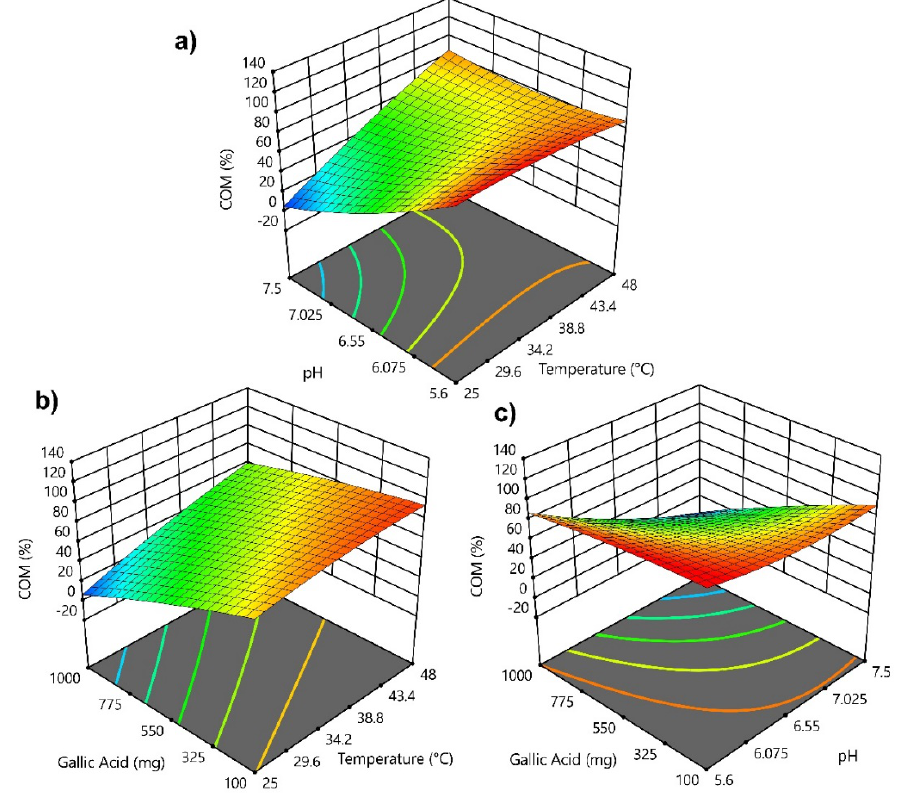
Figure 4 . 3D plots of the influence of individual parameters and their interactions: a ) temperature ( X 1 ) and system pH ( X 2 ), b ) temperature ( X 1 ) and added gallic acid ( X 3 ), c ) system pH ( X 2 ) and added ( X 1 ) and system pH ( X 2 ), ( b ) temperature ( X 1 ) and added gallic acid ( X 3 ), ( c ) system pH ( X 2 ) and gallic acid ( X 3 ) on the COM content response ( y ). added gallic acid ( X 3 ) on the COM content response ( y